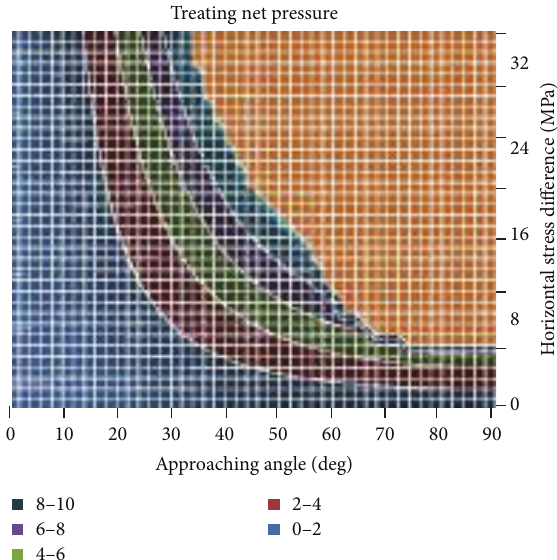
Figure 11: Net pressure of hydraulic fracture reorienting propa- gation along natural fracture for different approaching angles and horizontal stress